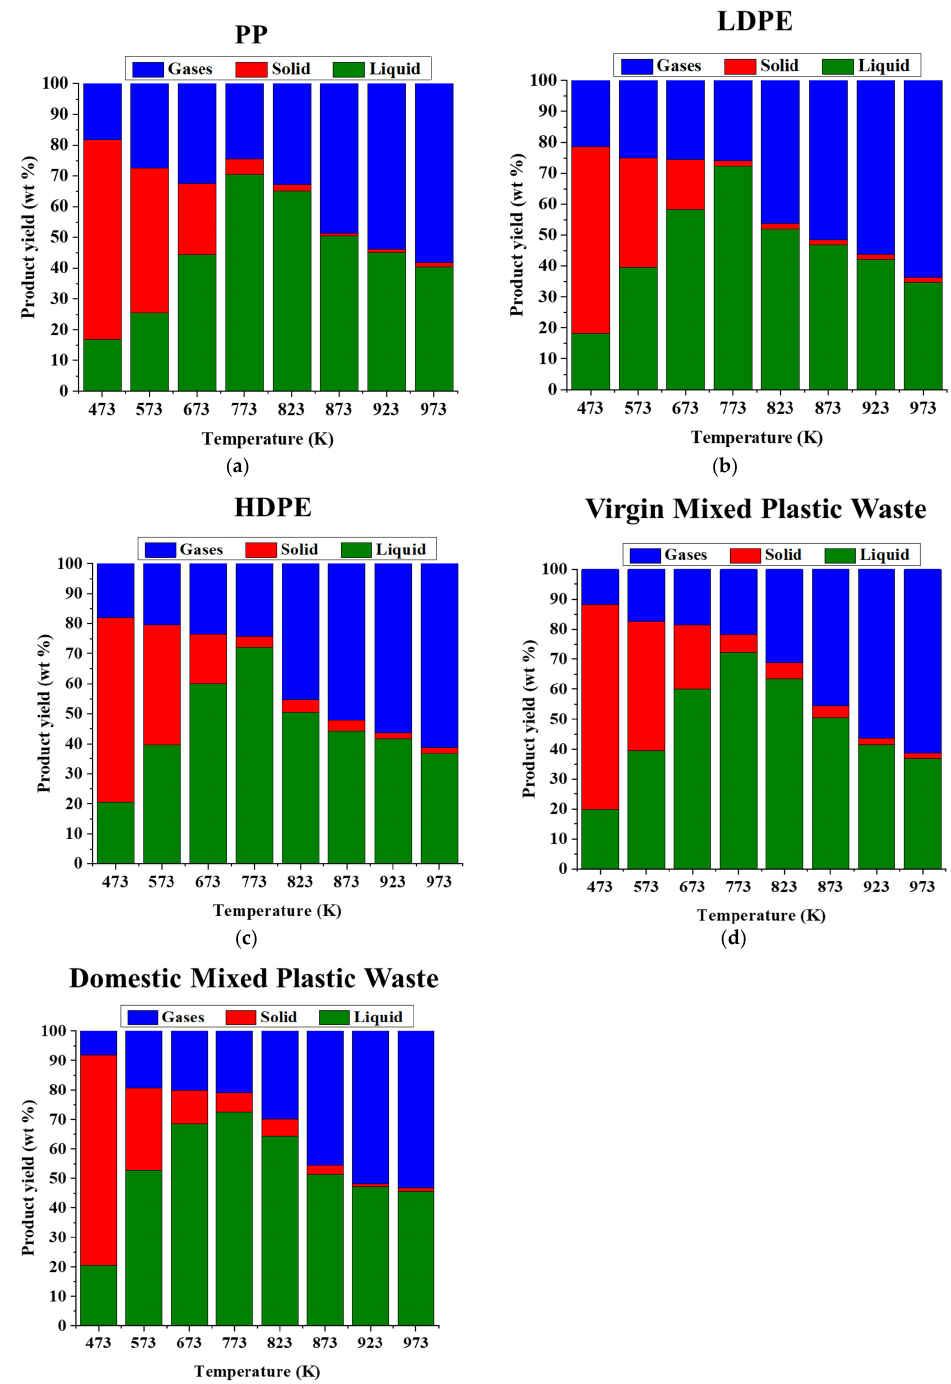
Figure 4. Different alternate fuels produced from ( a ) PP ( b ) LDPE ( c ) HDPE ( d ) Mixed virgin plastic ( e ) Domestic plastic waste (all products shown are produced at optimum temperature condition).